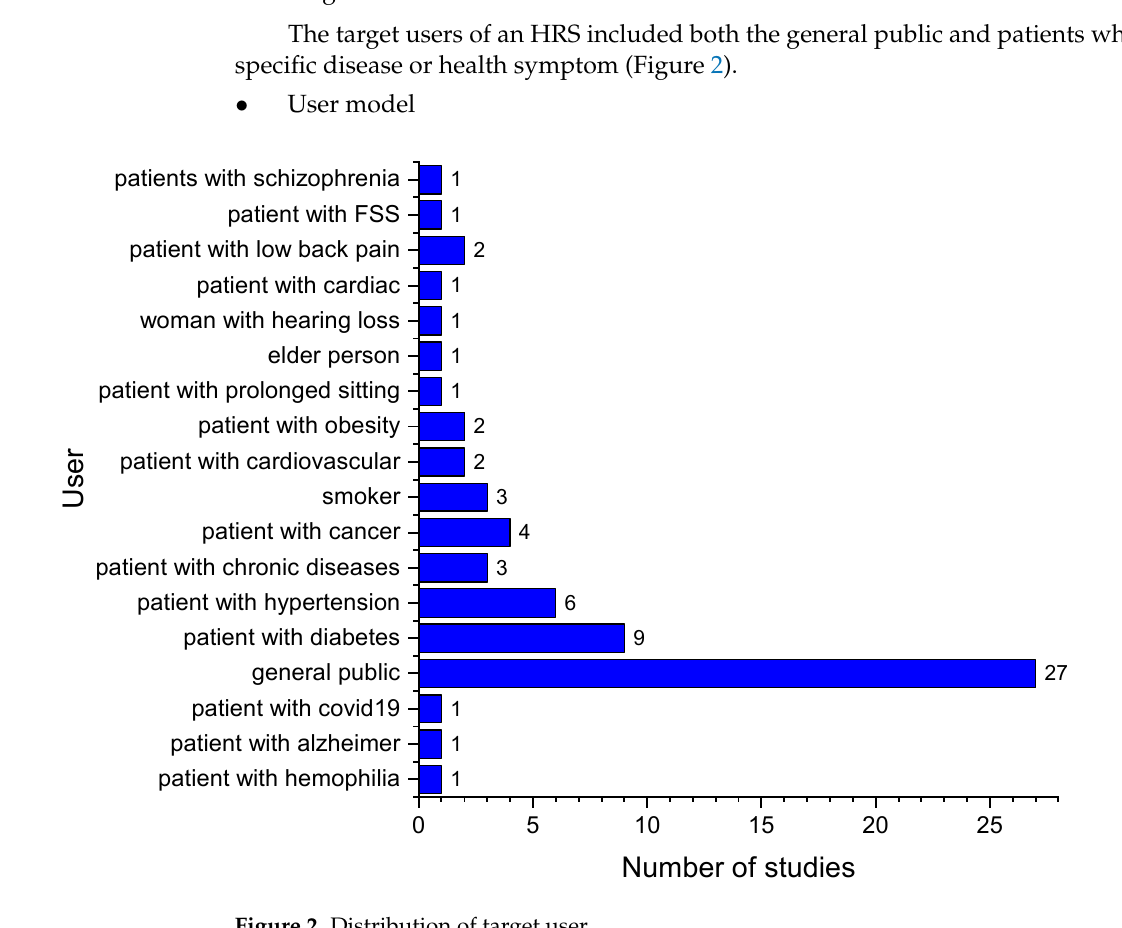
Table 3. Attributes of user model. User Attribute